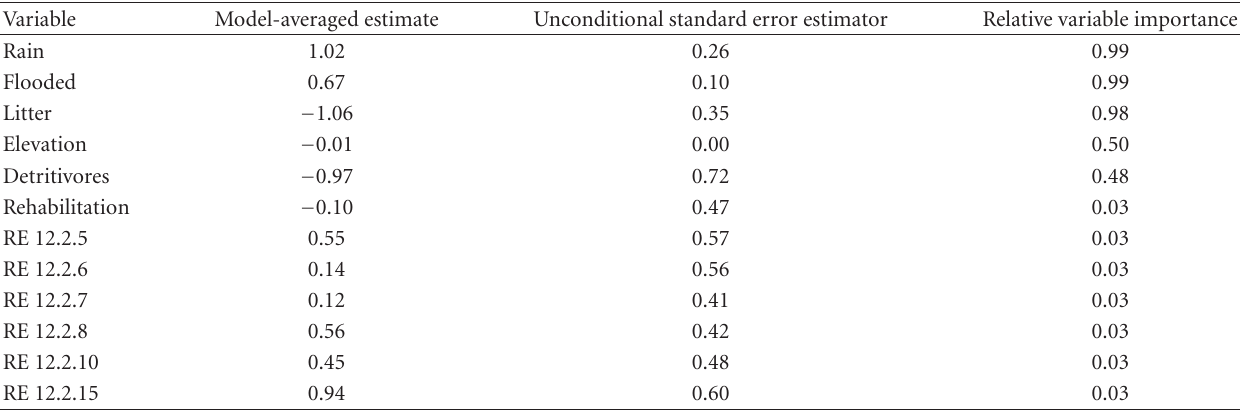
Table 5: Relative variable importance (by decreasing importance) across all models searching for environmental variables explaining koala scat decay.